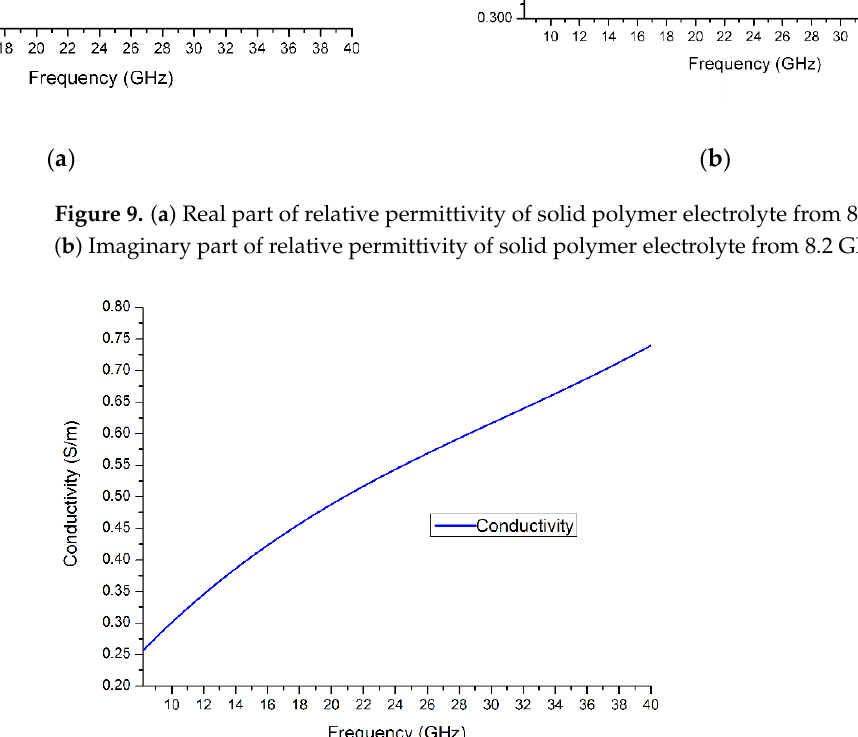
Figure 11. Cole – Cole curve of the polymer specimen.